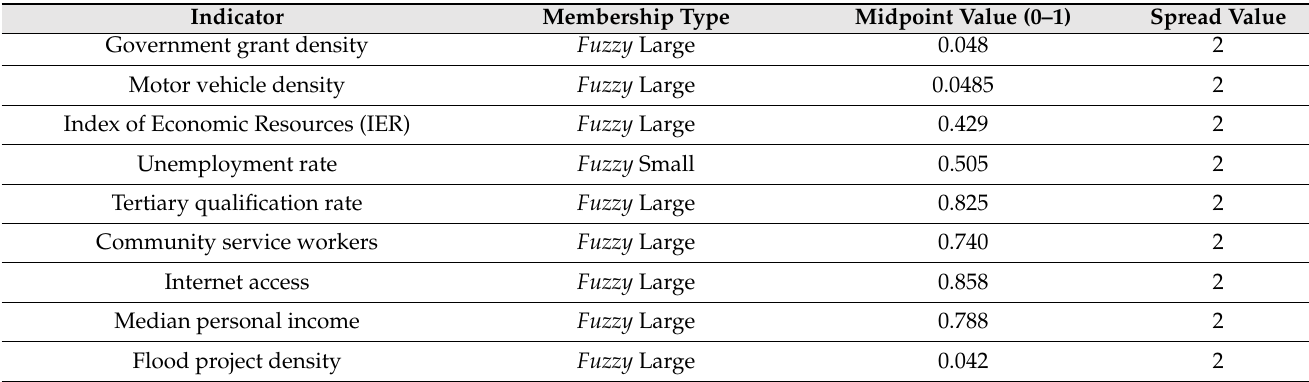
Table A1. Fuzzy standardising metadata for the Flood Resilience Index (via ArcMap 10.7